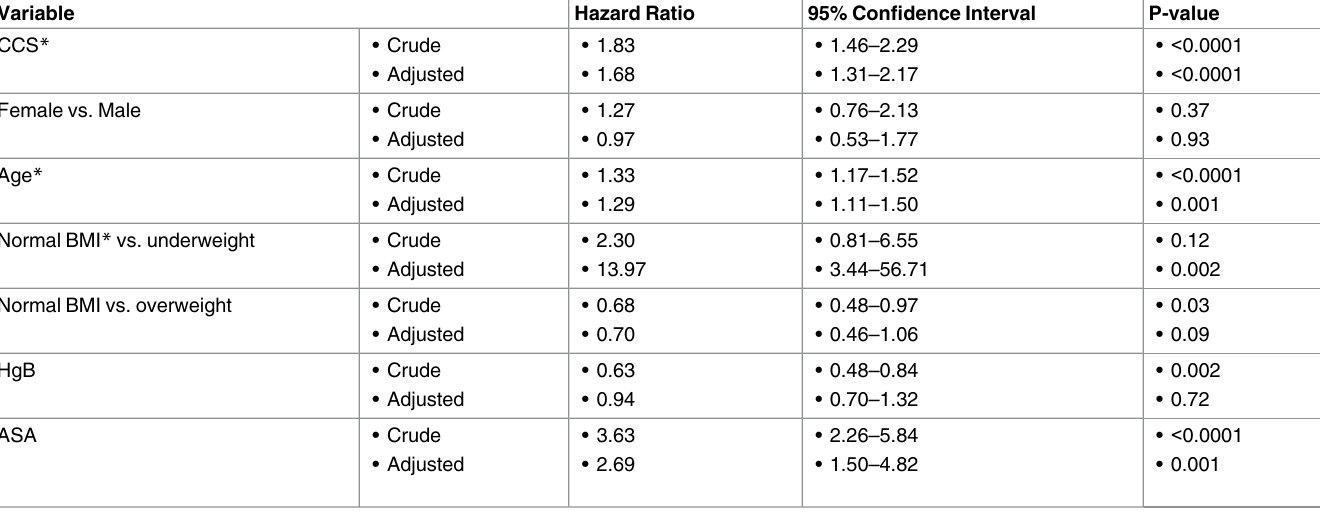
HgB: pre-operative hemoglobinlevel; ASA: American Society of Anesthesiologists score; BMI: Body Mass Index CCS: Charlson Comorbidity severity score. Multi-variable analysis are adjusted for Gender, Age, ASA, CCS, Hgb * Collapsed variable: age in 5-year intervals; BMI underweight ( < 18.5), normal weight (18.5–25), overweight ( > 25); CCS 0 co-morbidity , 1 co-morbidity (equally ranked), 2 co-morbidities (equally ranked), 3+ co-morbidities (equally